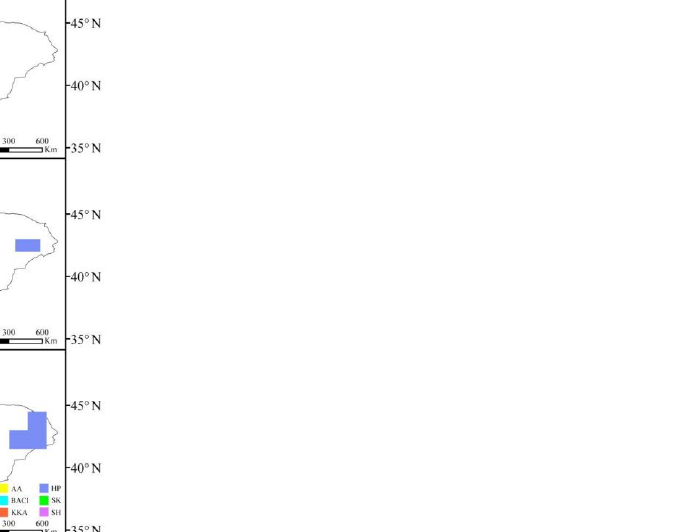
Figure 4. AOEs obtained for Tenebrionidae by PAE using three different cells in Xinjiang, China: ( A ) 0.5° grid size, ( B ) 1° grid size, and ( C ) 1.5° grid size.